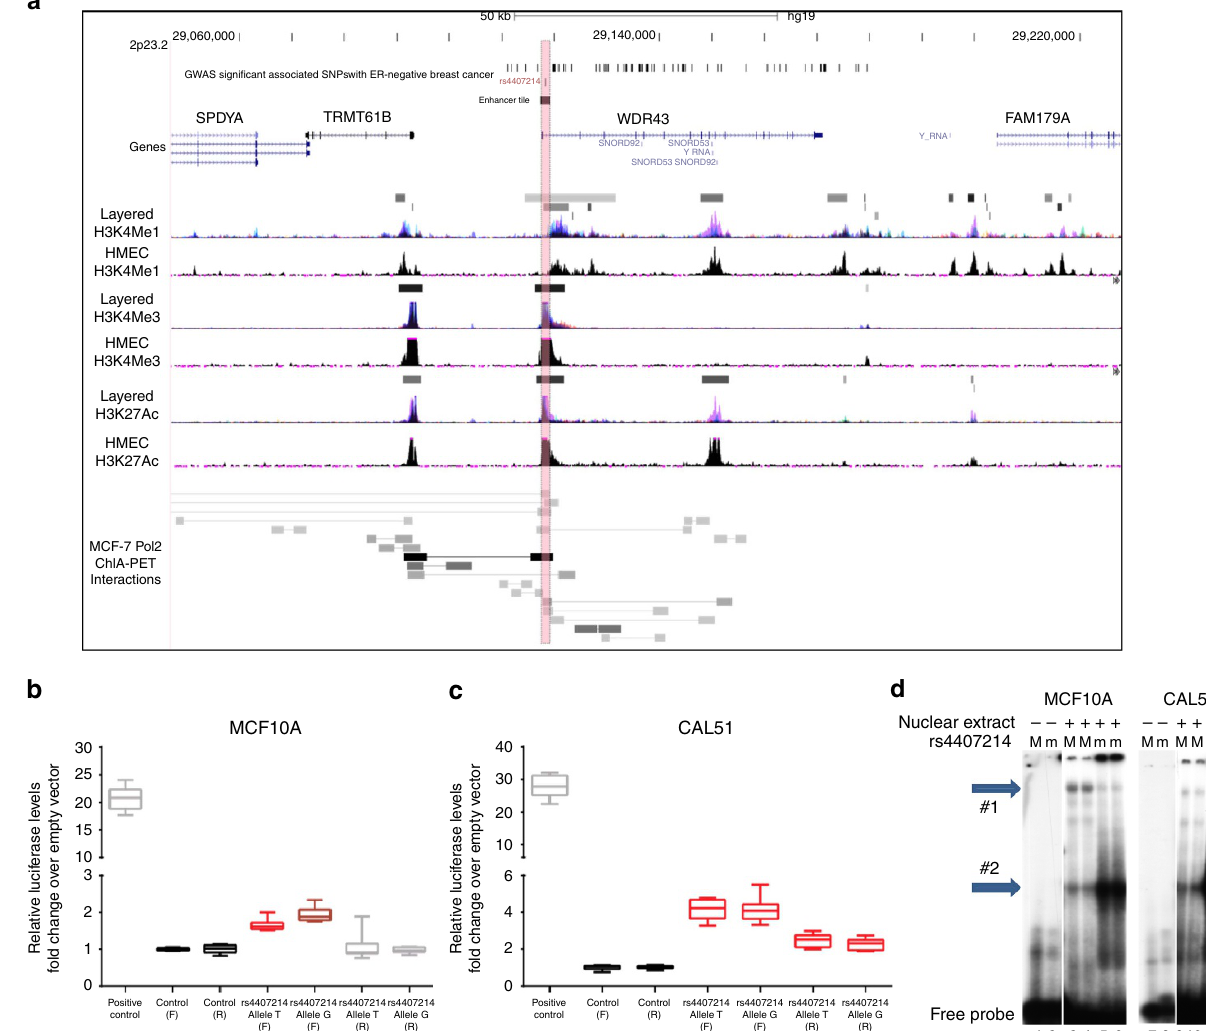
Figure 3 | The chromatin landscape of locus 2p23.2. ( a ) The SNP rs4407214 is included in a genomic tile overlapping chromatin features indicative of promoters and enhancers, shaded red. ( b , c ). Luciferase assays showing activity in the tile containing SNP rs4407214 (highlighted in pink in a .) in MCF10A and CAL51, red box plots indicate significantly different from the control tile ( P o 0.0001). Brown box plot indicates significant difference from the reference allele ( P ¼ 0.0059). ( d ) Electrophoretic mobility shift assay (EMSA) showing the formation of allele-specific complexes for rs4407214. M, major allele; m, minor allele. Lines 1, 2, 7, 8—no nuclear extract. Lines 3, 4, 5, 6—10 m g of MCF10A nuclear extract. Lines 9, 10, 11, 12—10 m g of CAL51 nuclear extract. Shift detected by comparison to bands (arrows #1 and